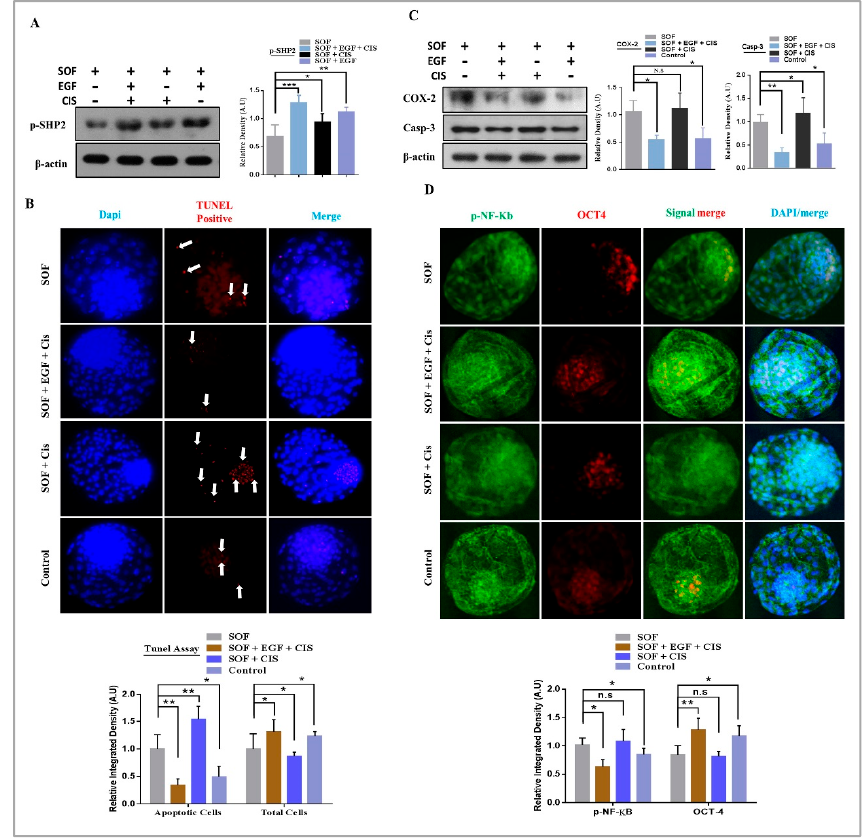
Figure 3. EGF neutralize cisplatin induced apoptosis and enhances the developmental rate of blastocysts. ( A ) Western blot analysis of SHP2 in blastocysts grown in SOF, COMBO, CISPLATIN